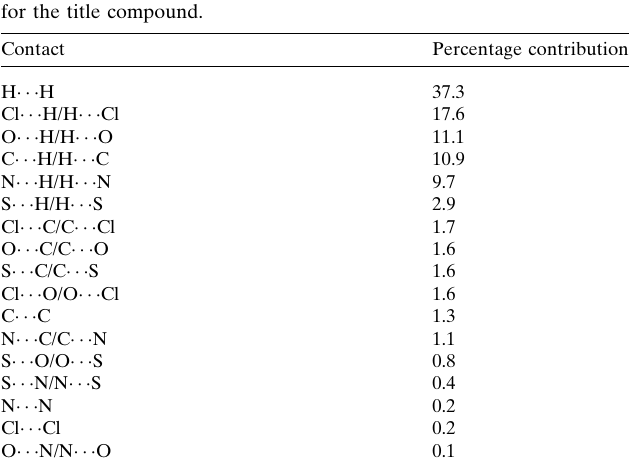
in Table 2. The O—H (cid:2) (cid:2) (cid:2) O and N—H (cid:2) (cid:2) (cid:2) O hydrogen bonds are clearly shown by the dark-red circles (Tables 1 and 2; Fig. 4).